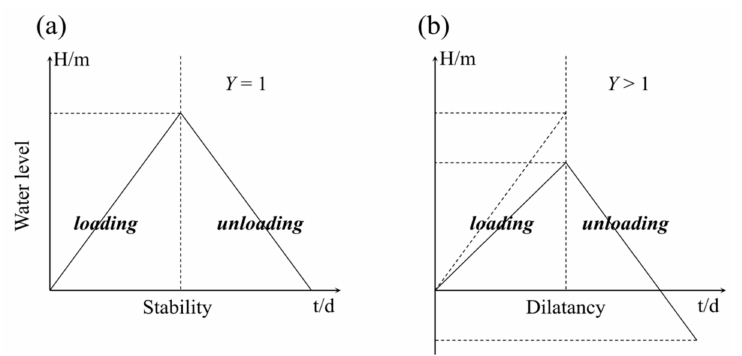
Figure 2. Schematic view of influence of rock dilatancy on the changes of water level and LURR. When the system is in the stable stage ( a ), there is no difference between water level during the loading and unloading phases, so Y = 1. When the system is in the dilatant stage ( b ), the void volume leads to the difference between water level during the loading and unloading. Because the void volume in the loading is far more than that of the unloading, the average water level in the loading and unloading is different, and Y >